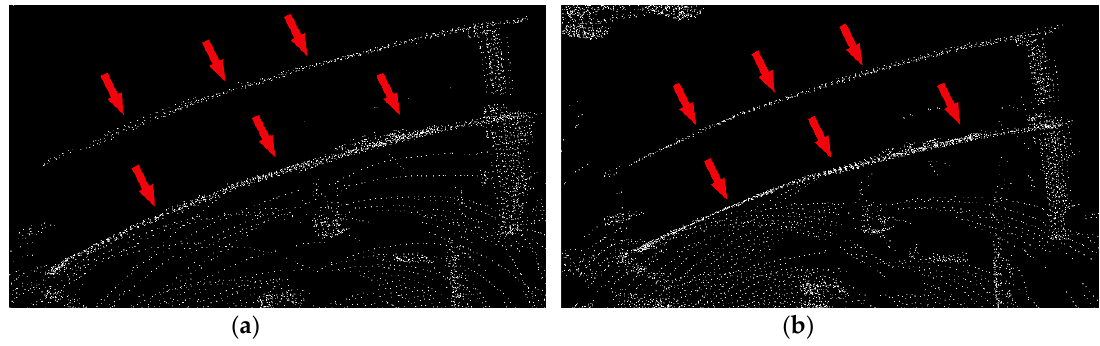
Figure 18. Clouds represent the red comparison area in detail in Figure 17. Two walls were pointed out by red arrows. ( a ) Represents the raw point cloud; ( b ) is processed with our de-skewing approach.